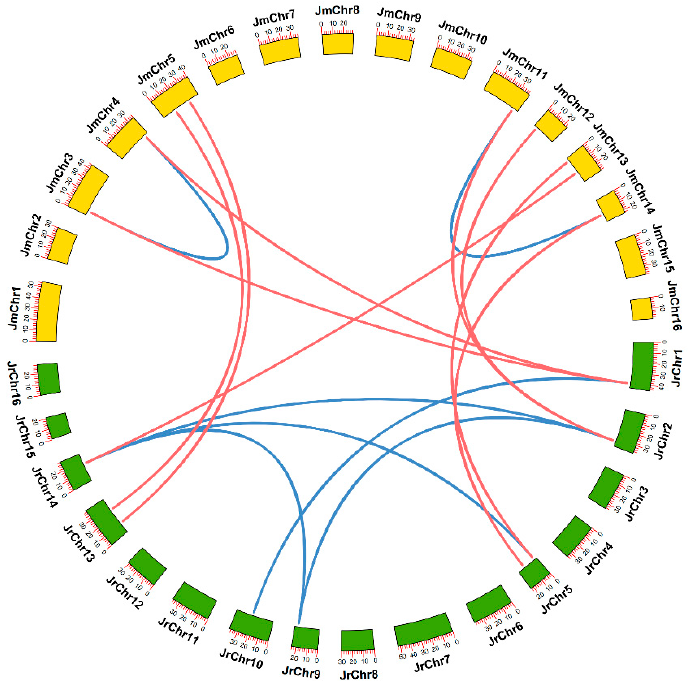
Figure 4. Genome ‐ wide synteny analysis of YABBY genes for J. regia and J. mandshurica . Ortholo ‐ gous and paralogous YABBY genes were mapped onto the chromosomes and linked by each other. Red lines indicate orthologous gene pairs, blue lines indicate paralogous gene pairs.